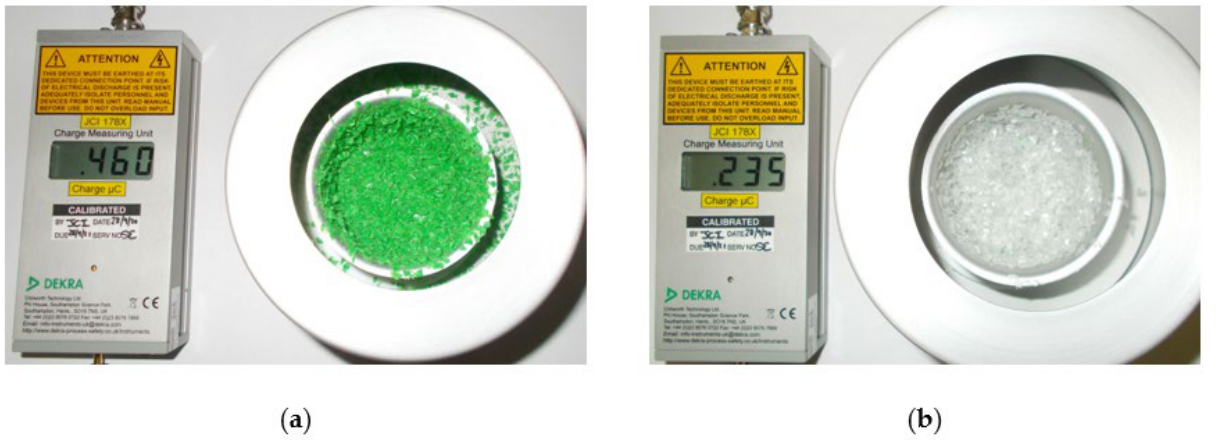
Figure 4. A system for measuring the accumulated charge on particles of ( a ) PE-HD and ( b ) PET polymers.